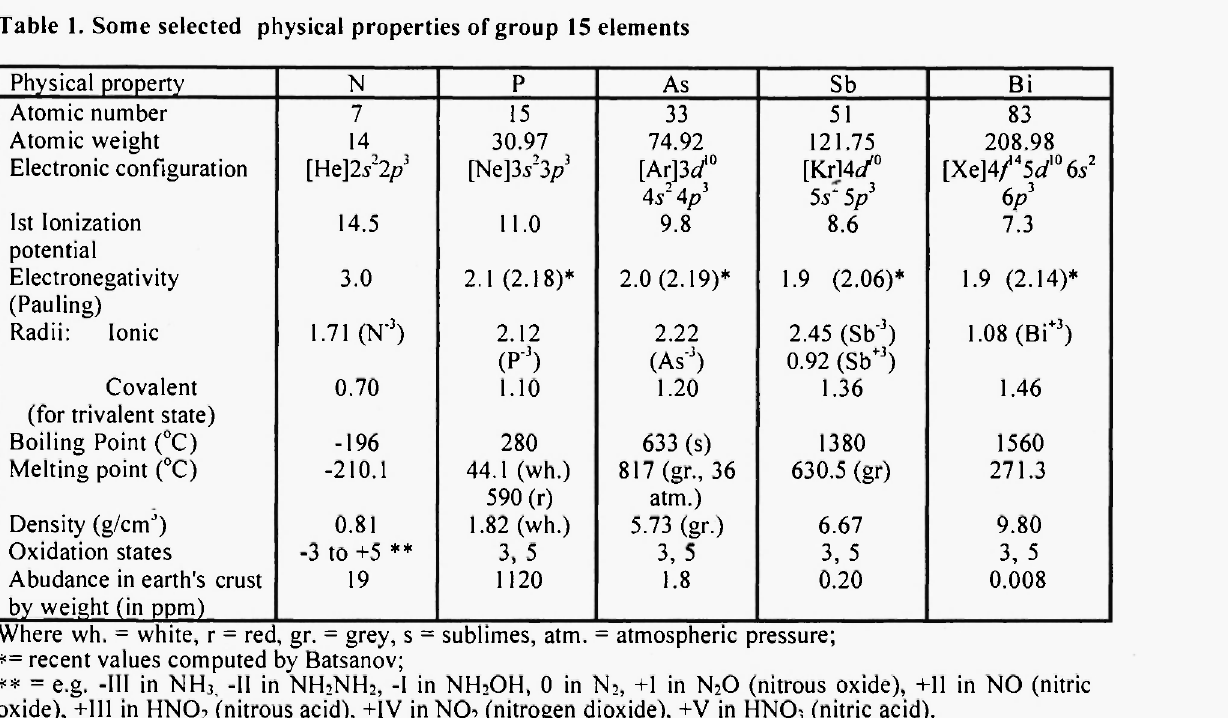
Table 1. Some selected physical properties of group 15 elements